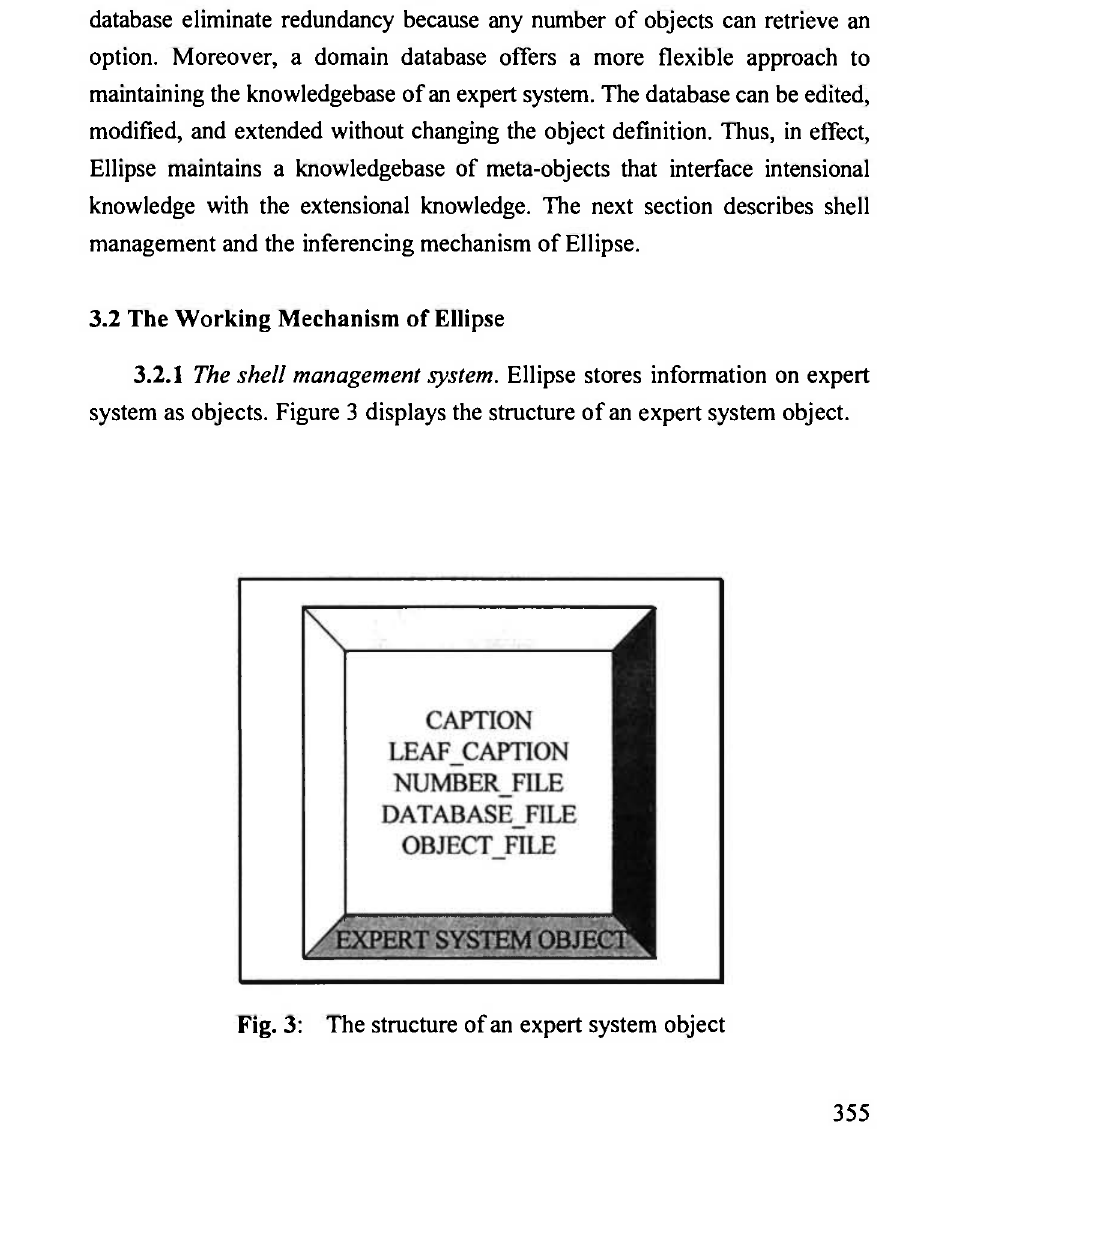
Fig. 3: The structure of an expert system